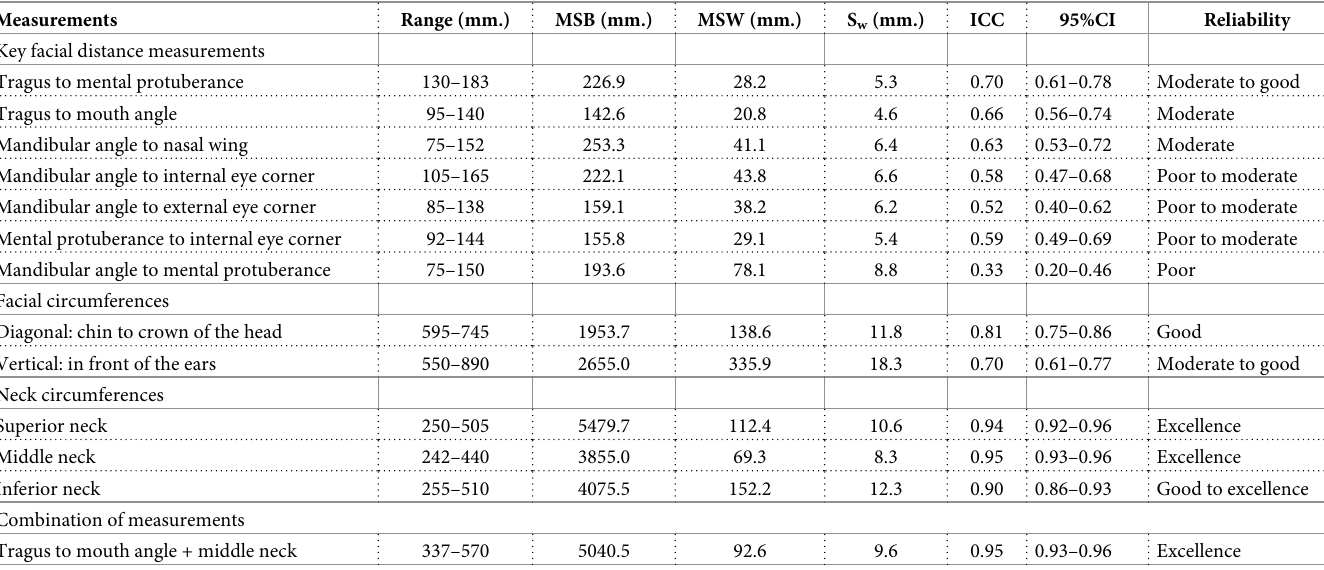
Table 2. Analysis of the precision and reliability of the tape